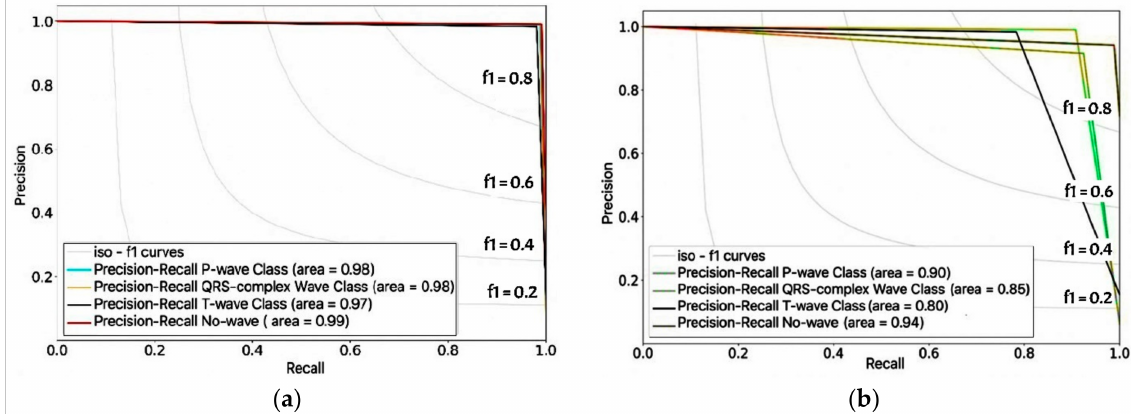
Figure 7. Model evaluation based on precision–recall (P–R) curves. ( a ) intra-patient data. ( b ) inter-patient data.